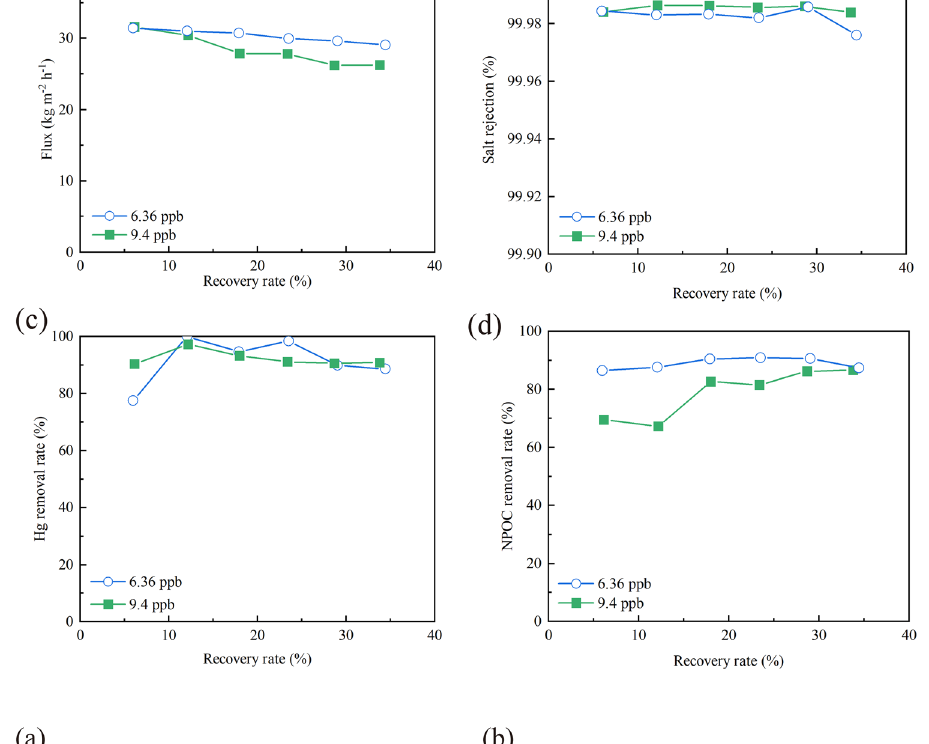
Fig. 6 Pervaporation perfor- mance of c-GO-PEI at different temperatures: a Flux and salt rejection; b Hg and NPOC removal rates